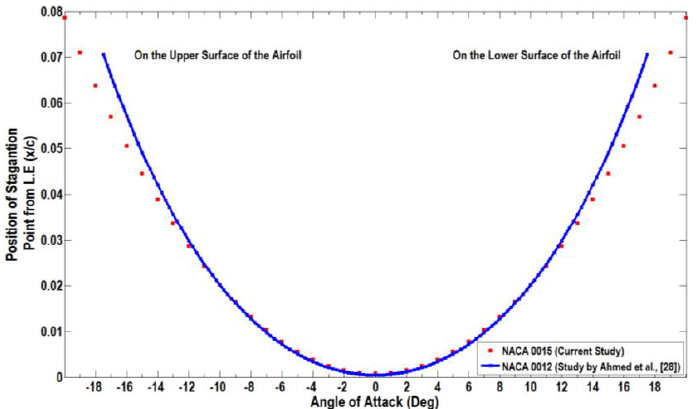
Figure 7. Variation of the stagnation point position with the angle of attack.